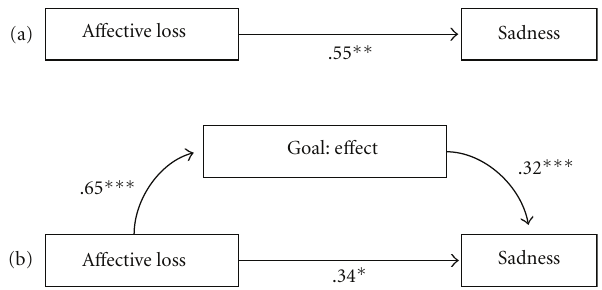
Figure 3: Path models showing total e ff ect (a) and mediated e ff ect (b) of a ff ective loss on sadness. Note: coe ffi cients are unstandardized. ∗ P < . 05; ∗∗ P < . 001; ∗∗∗ P < . 0001.